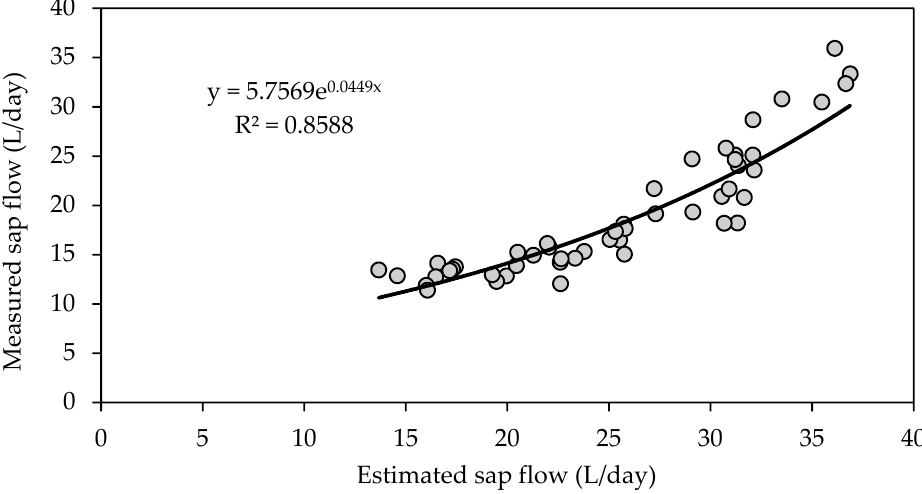
Figure 10. Relationship between measured and estimated sap flow.